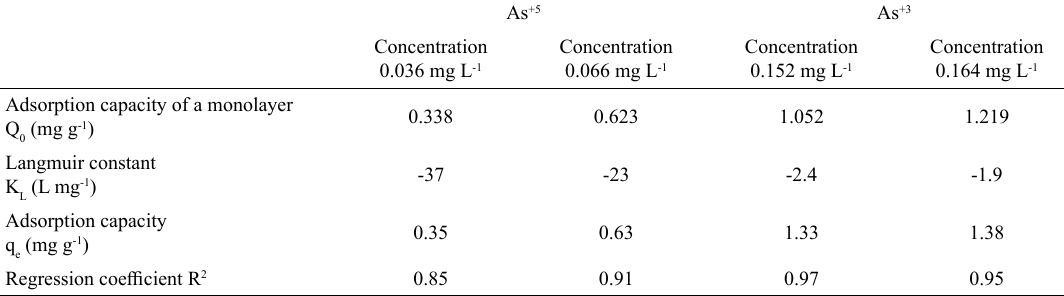
Table 5: Results from the Langmuir model for the adsorption of As ions (As +3 y As +5 ) on the